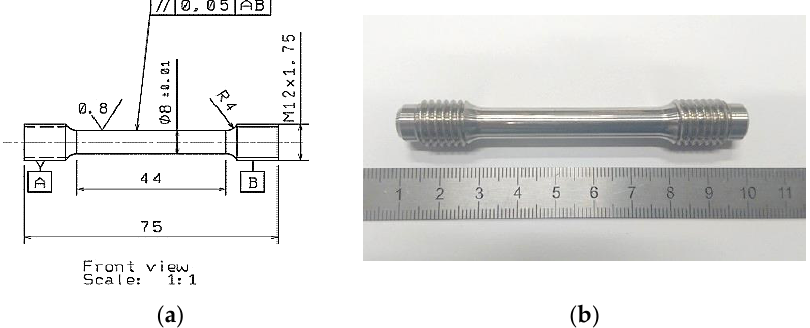
Figure 4. ( a ) Geometry of used tensile test samples and ( b ) SLM sample prepared for tensile testing.